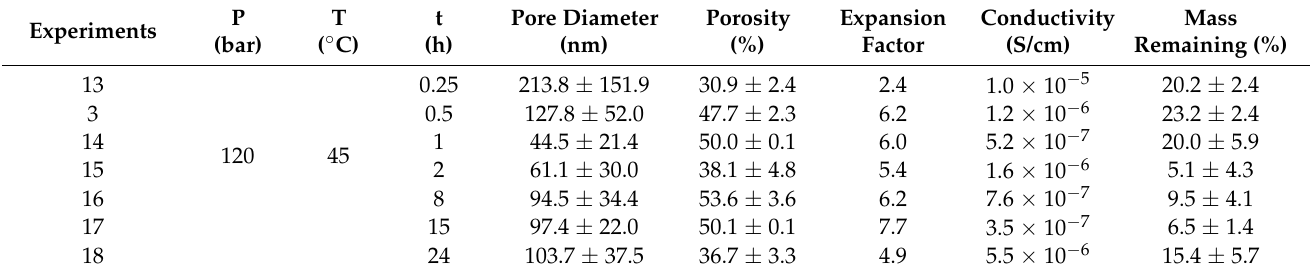
Table 3. Supercritical foaming experiments to evaluate the influence of contact time on the process.